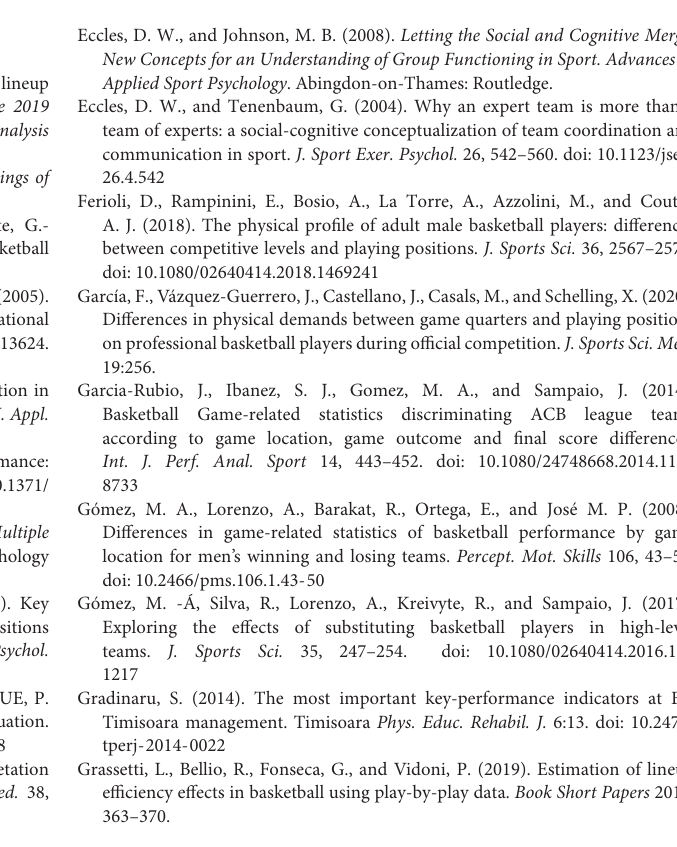
Supplementary Table 1 | The anthropometric, technical and tactical data of all the 525